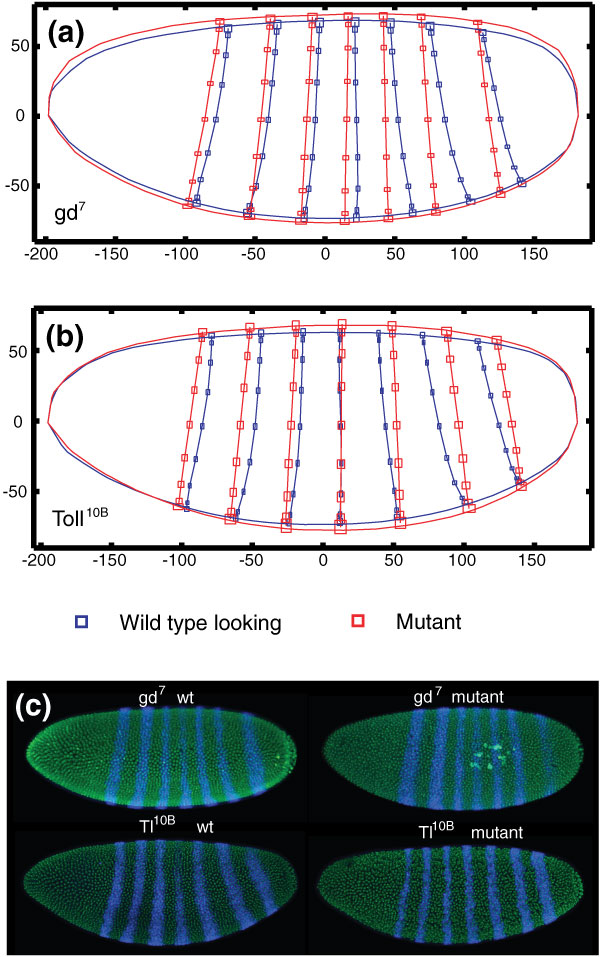
gd and Tl regulate ftz stripe location. Quantitative comparison of ftz expression (a) between mutant embryos derived from gd7 homozygous mothers and wild-type-like embryos derived from gd7 heterozygous mothers and (b) between mutant embryos derived from Tl10B homozygous mothers and wild-type-like embryos derived from Tl10B heterozygous mothers; both show lateral orthographic projections indicating the position of each of the seven stripes in wild-type-like embryos (blue stripes) and mutant embryos (red stripes). All embryos were from stages 5:25-75%. The confidence intervals, embryo orientation, and scales are as described in Figure 4. Shifts in the ftz expression boundaries are consistent with dorsalized (gd) and ventralized (Tl) nuclear flow, respectively. (c) The effects of disrupting the d/v system on stripe curvature and placement in single embryo images, shown in a lateral view. The stripes in the mutant embryos (right) clearly differ from those in the wild-type-like embryos (left), but because of small differences in embryo orientation and shape it is difficult to draw a precise understanding of how stripe locations have changed from such raw image data.